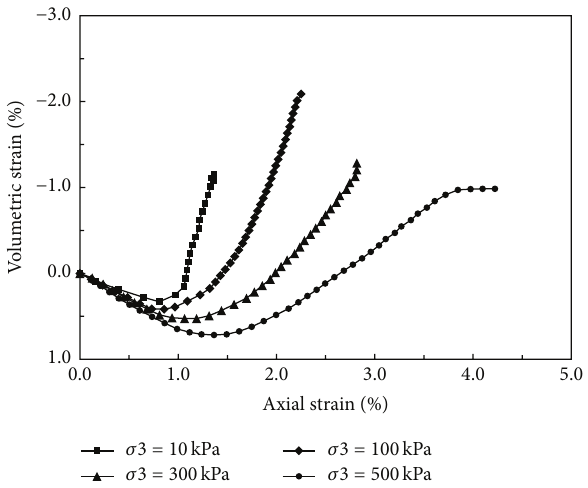
Figure 3: Volumetric strain-axial strain curves of simulated soft rock specimen.